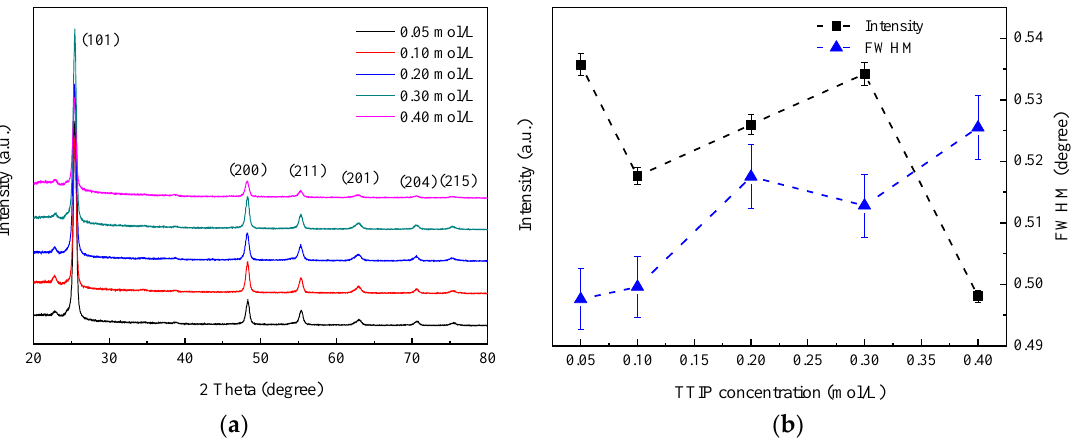
Figure 8. GIXRD results of TiO 2 films deposited with different TTIP concentrations by mist CVD method. (( a ) GIXRD patterns of TiO 2 films; ( b ) (101) peak intensity and FWHM of TiO 2 films).